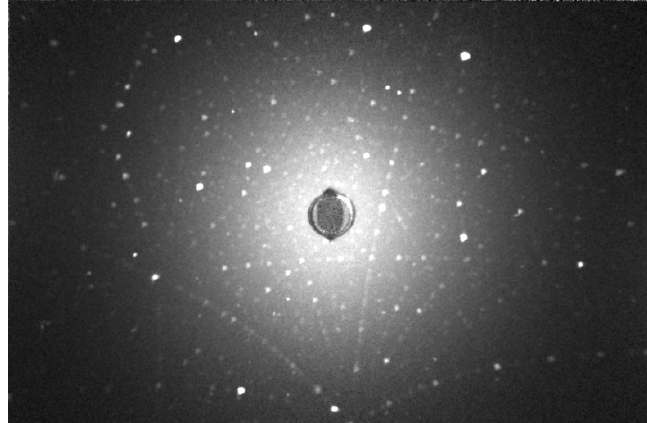
Figure 3. The Laure photograph of the as grown Ce, Pr:LuAG crystals.